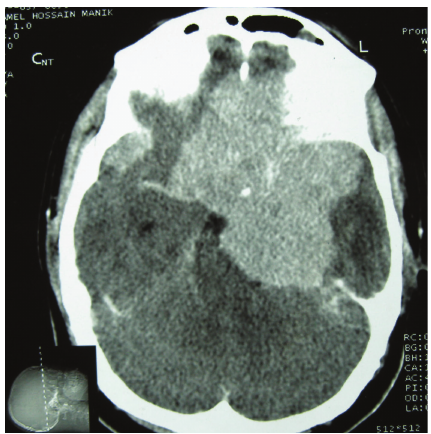
Figure1:CTscanofbrainshowingthatthelesionhasencircledboth optic nerves.